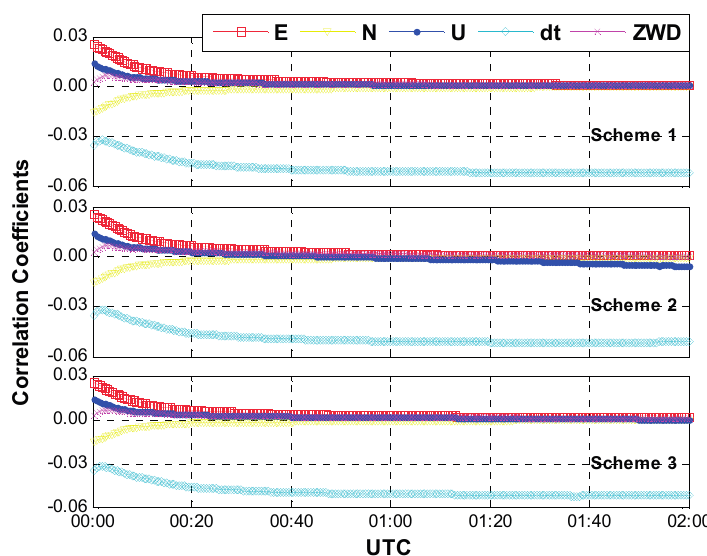
Figure 8. Correlation coefficients between ISB and other parameters (case one: sufficient number of GPS and GLONASS satellites, an average of 15 satellites included).